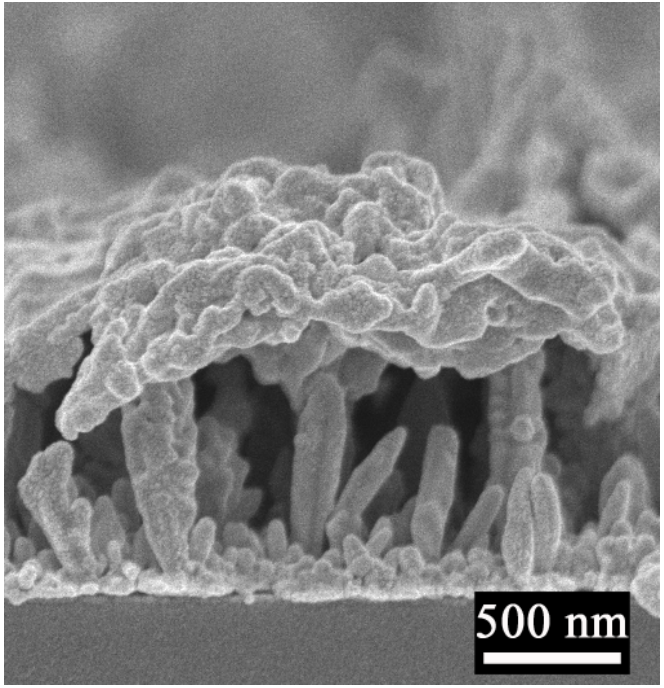
Figure 6. SEM image of PTBL cast on Au nanobranch surface, which prepared by electrochemical deposition at -0.2 V for 800